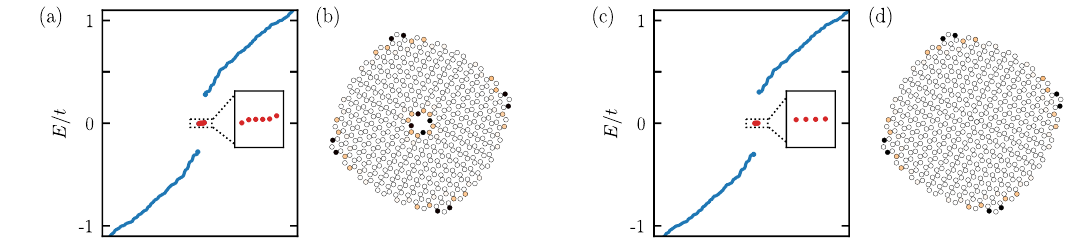
Figure 13: 2D second-order class D model from Eq. (14) with a 2 π/ 3 disclination: = 1.5 and t = 0.5. (a) shows the spectrum close to E = 0 for model parameters t 1 2 a disclination for which the central sites have been removed [ similar to Fig. 12(c) and (d) ] . We find four zero modes localized to the four corners of the lattice and two finite-energy mid-gap states at the disclination (see inset). In (b), we visual- ize the real-space weights of these six modes. The two finite-energy modes are not anomalous and can be pushed into the bulk spectrum by a local deformation at the disclination. This is explicitly demonstrated in (c) and (d) by recovering the four central sites at the disclination.